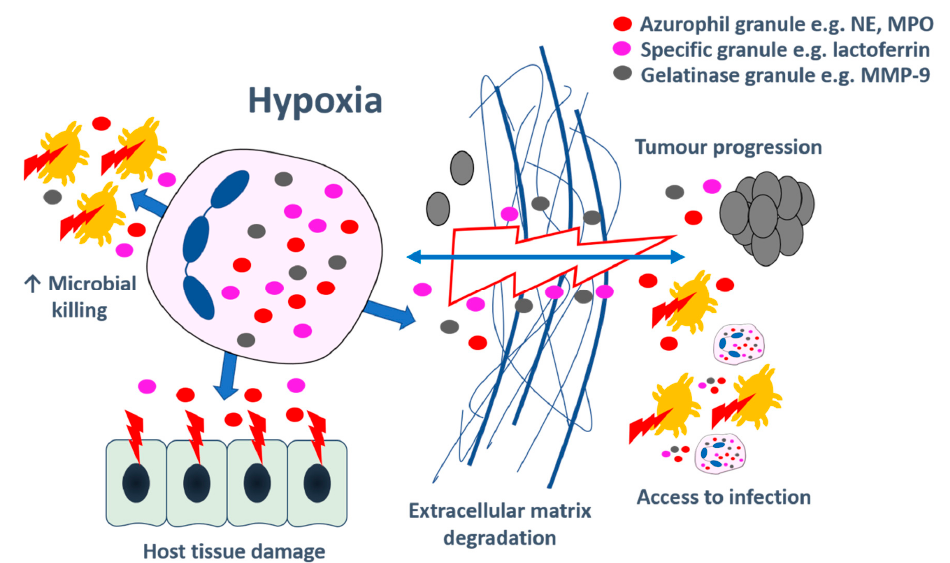
Figure 2. Consequences of hypoxia ‐ enhanced neutrophil degranulation. Hypoxia increases